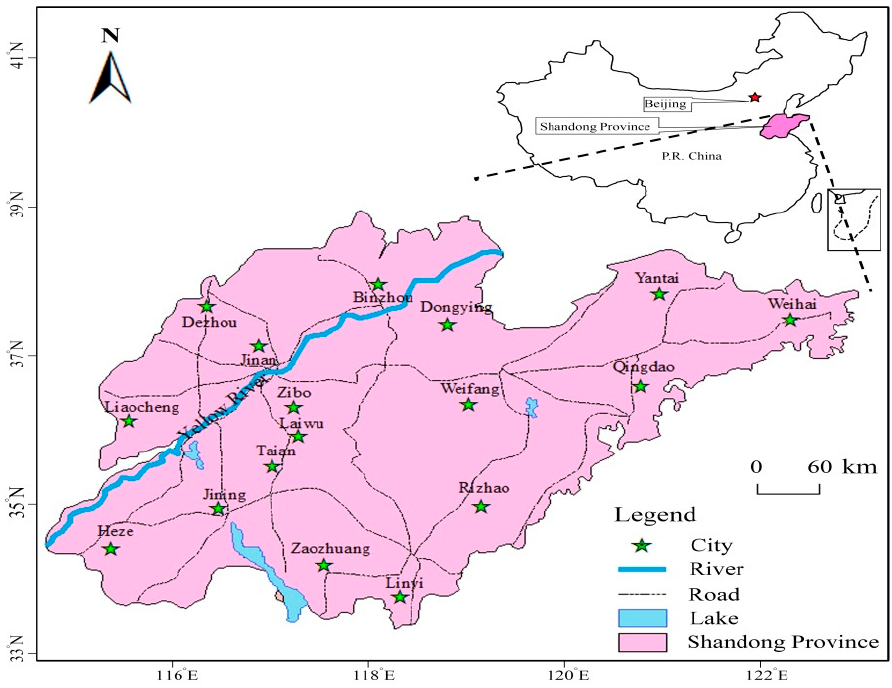
Figure 1. Location of Shandong Province and its seventeen prefecture-level cities.